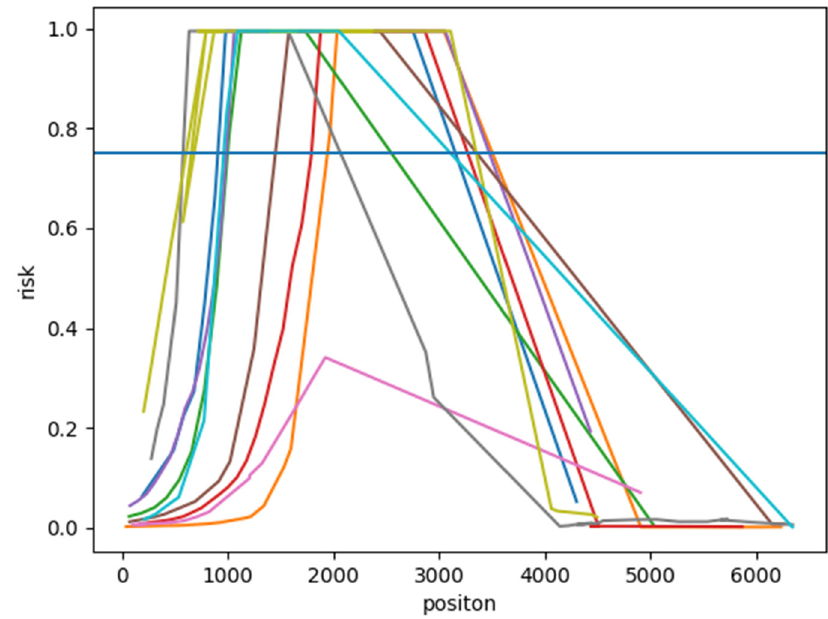
Figure 8. Chart of warning range.